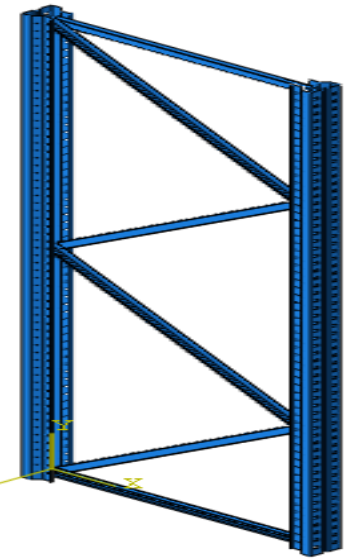
Fig. 4. Typical B1 type frame with inclined bracing only [12].